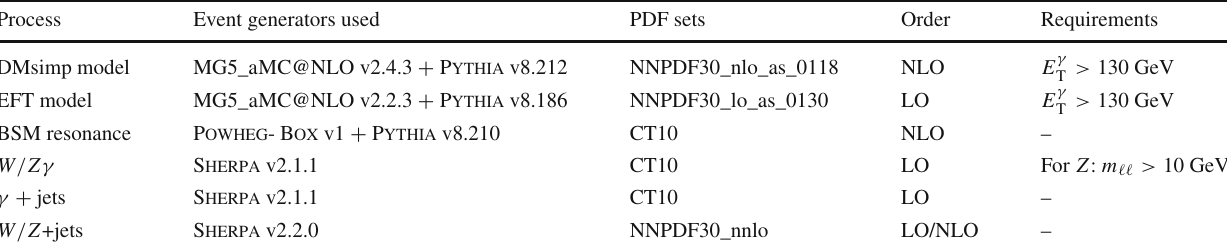
Table 1 Details of the generation of the signal samples and of the SM background processes considered in the analysis Process Event generators